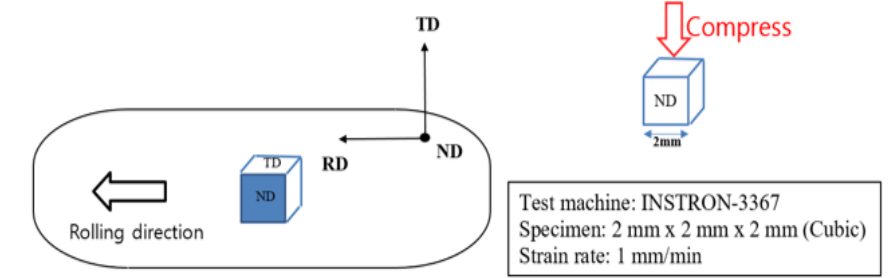
Figure 2. Sampling and compression of the specimens. RD: rolling direction; TD: transverse direction; ND: normal direction.